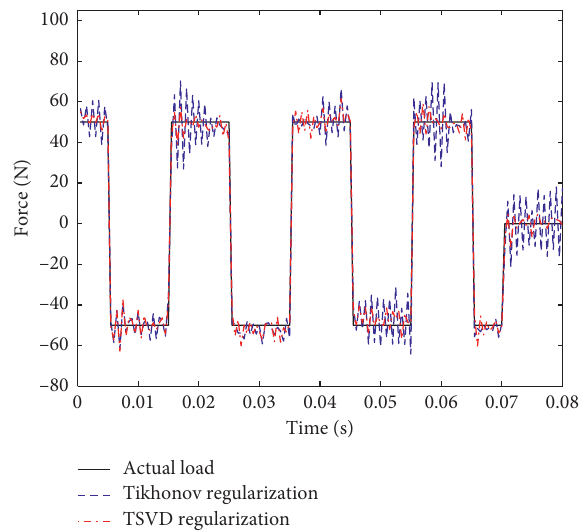
Figure 8: Identification results of wave loads under 5% noise. Table 2: Load identification results at five time points under 5%